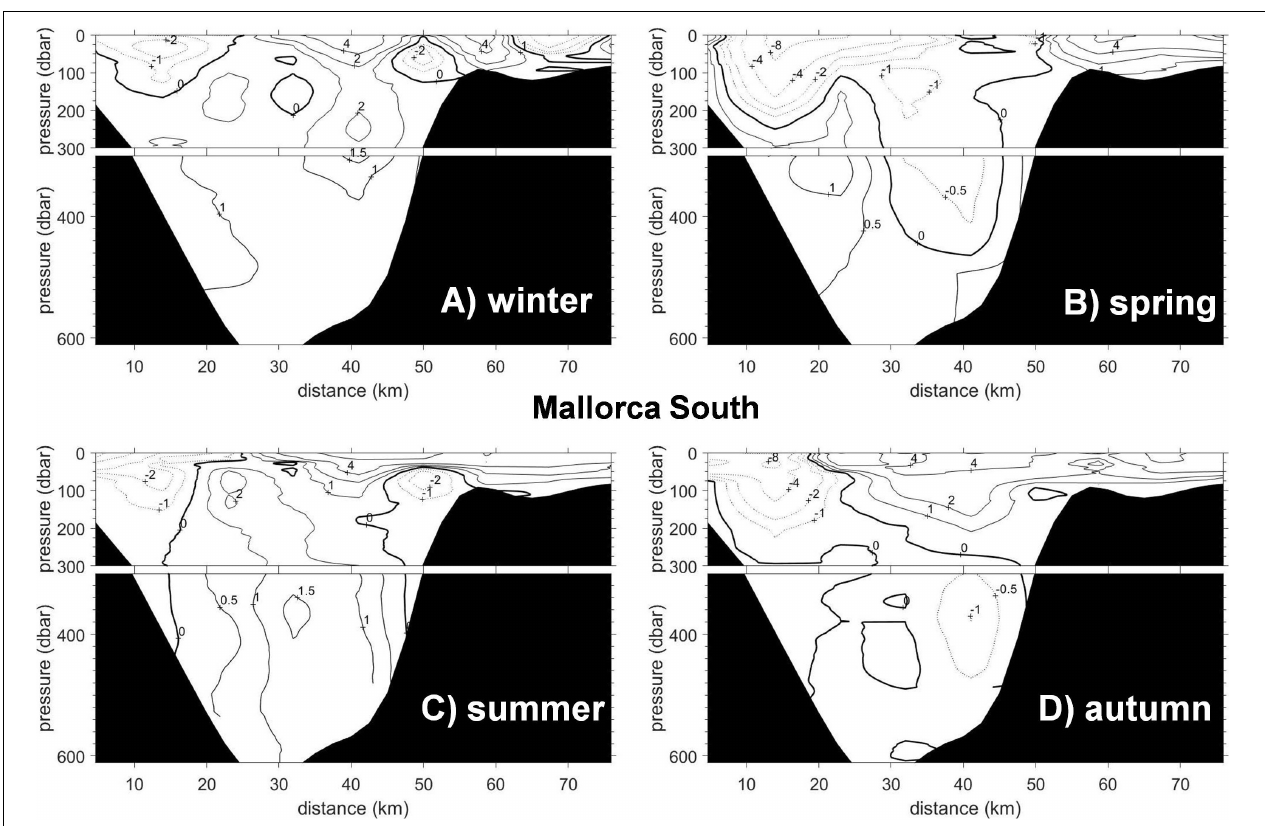
FIGURE 11 | Same as figure for the Mallorca South section. Winter (A) , Spring (B) , Summer (C) , Autumn (D)